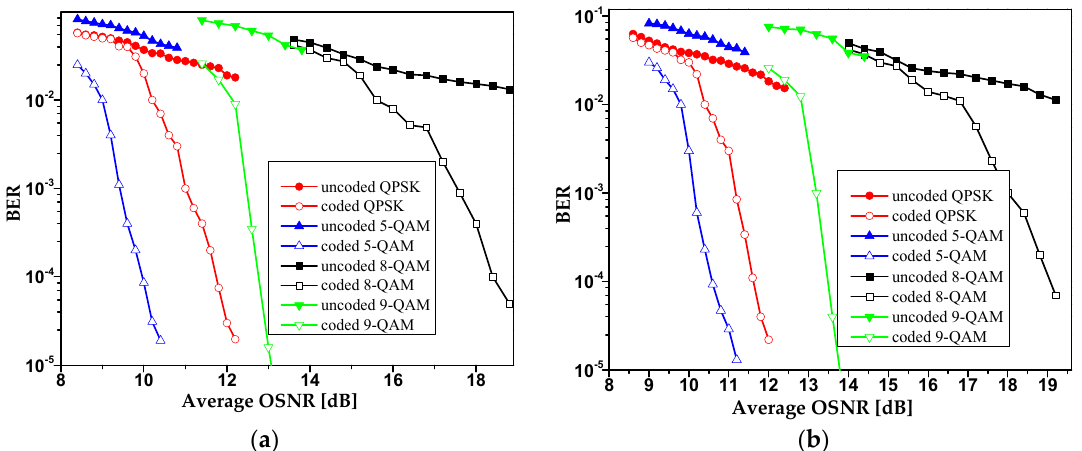
Figure 7. BER vs. average OSNR under an atmospheric turbulence limited environment, when ( a ) OAM state 2 is under testing; ( b ) OAM state − 6 is under testing.